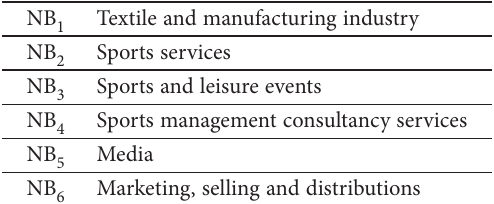
Table 3. Sports industries business opportunity NB Textile and manufacturing 1